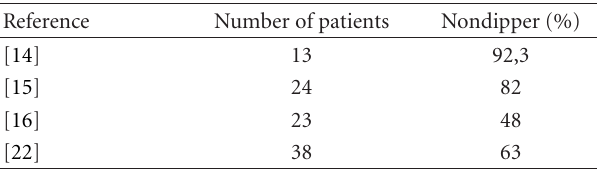
Table 4: Ambulatory blood pressure monitoring in patients with Parkinson’s